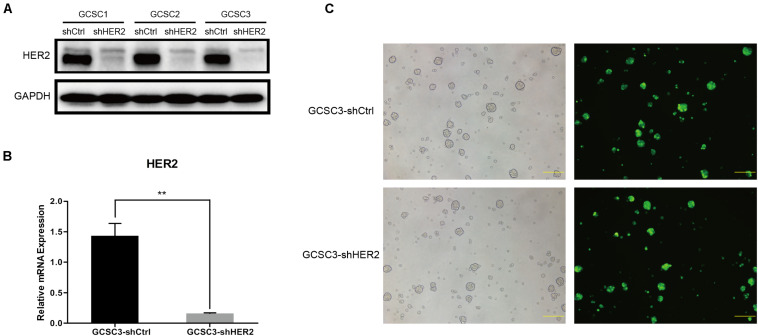
Construction of stable transformants. (A) Transfection efficiency detected by Western blot; GCSC3 had the highest efficiency of HER2 knockdown. (B) Transfection efficiency of GCSC3 detected by RT-qPCR (p < 0.01), **p < 0.01. (C) GCSC3-shCtrl and GCSC3-shHER2 under a fluorescent microscope; representative pictures were taken at ×100 magnification, and scale bars represent 200 μm.